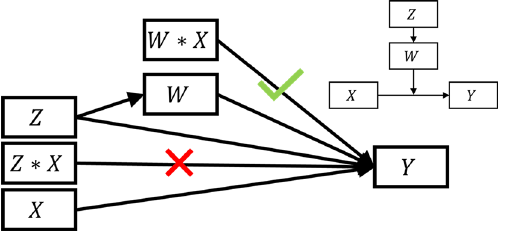
Path Model Related to the Indirect Moderation Model